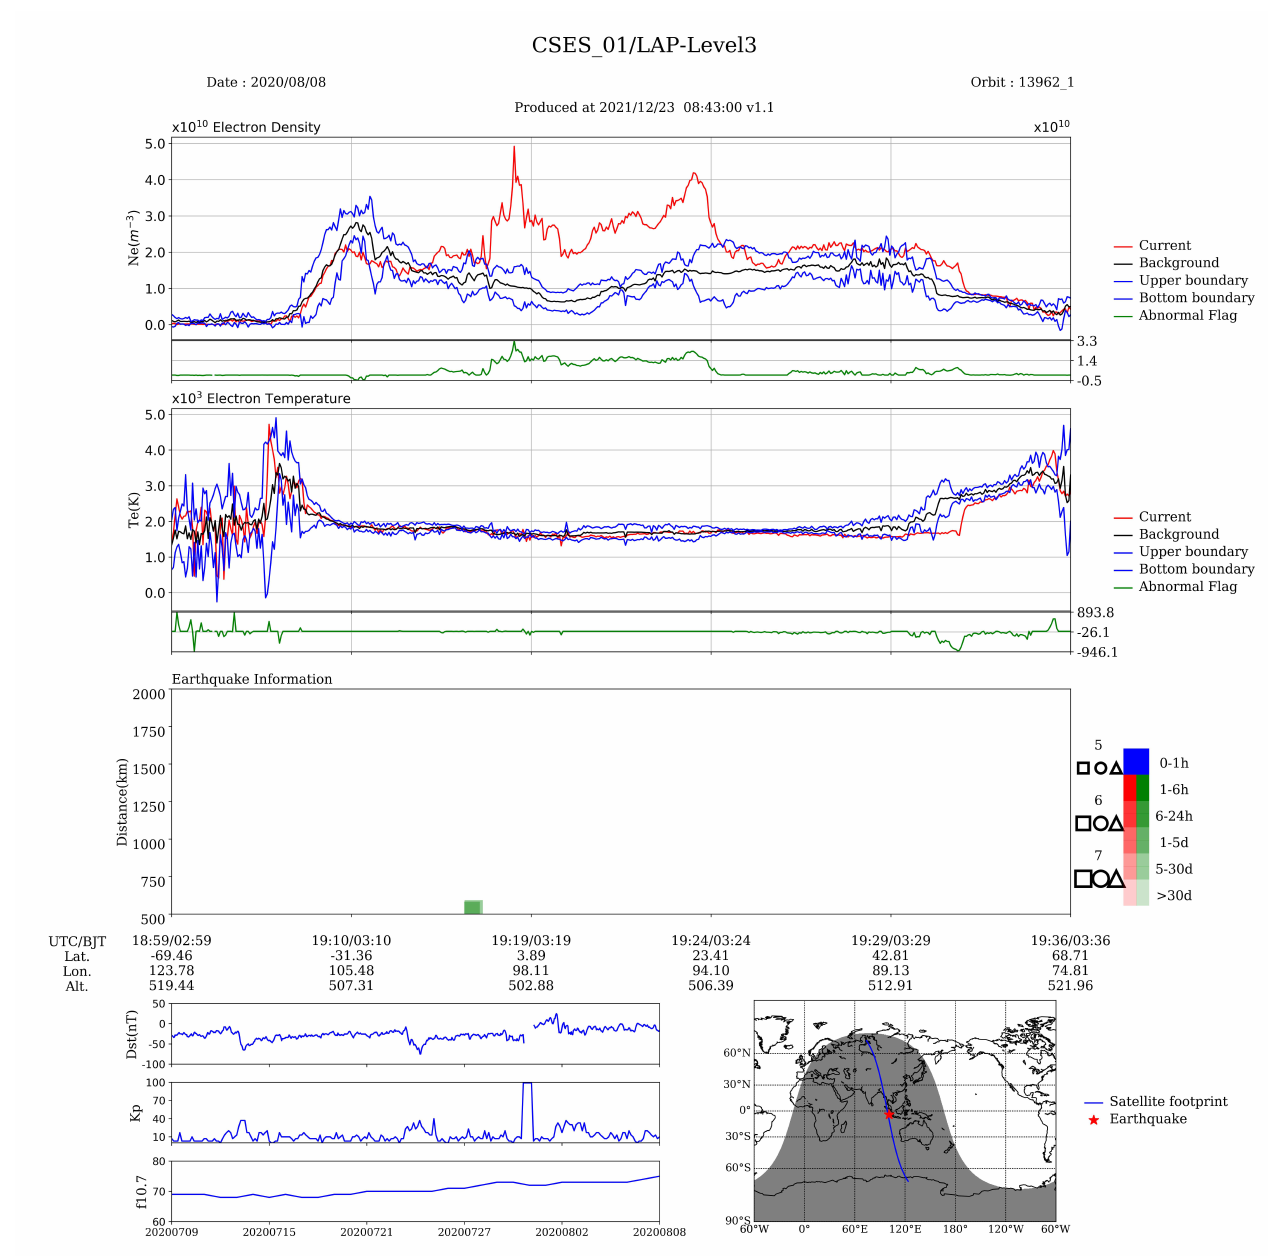
Figure 2. The typical Level 3 data automatically produced in the CSES scientific application center, taking the example of electron density observation from orbit No. 13962-1 on 8 August, ten days before the 18 August 2020, M 7.0 Sumatra EQ. See text for details about the meaning of each plot and displayed